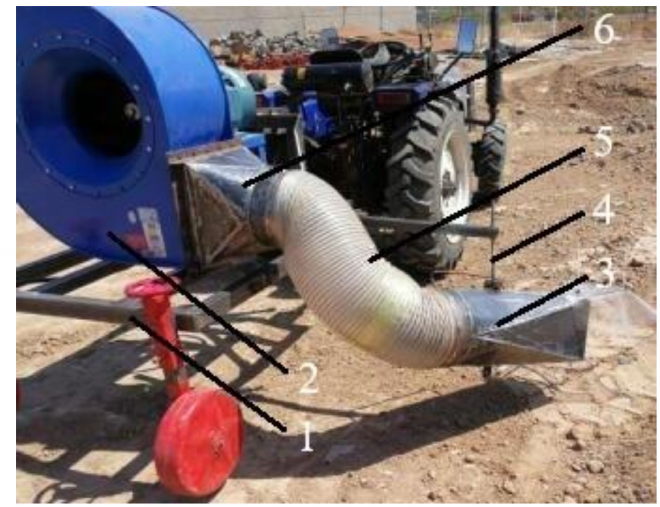
Figure 20. Principle prototype. 1: chassis, 2: centrifugal fan, 3: windpipe, 4: fan outlet transfer tube, 5: hose, 6: windpipe adjustment